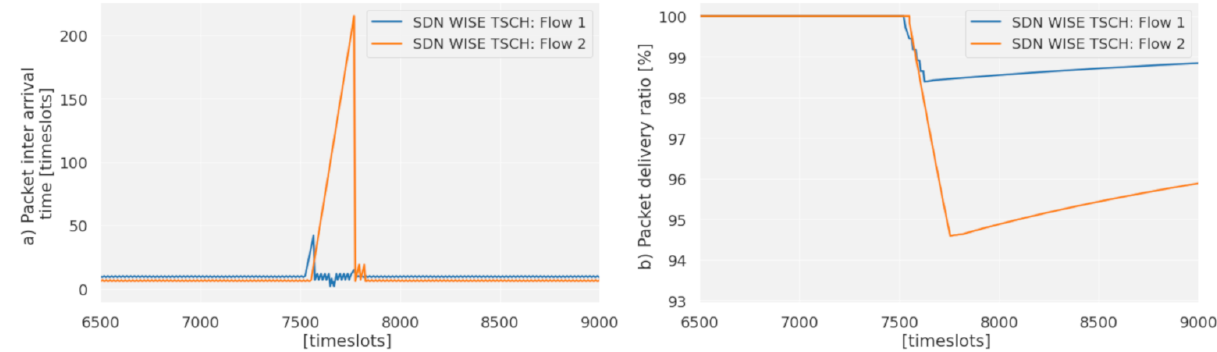
Figure 13. Path change after node 8 failure; ( a ) Packet inter arrival time; ( b ) Packet delivery